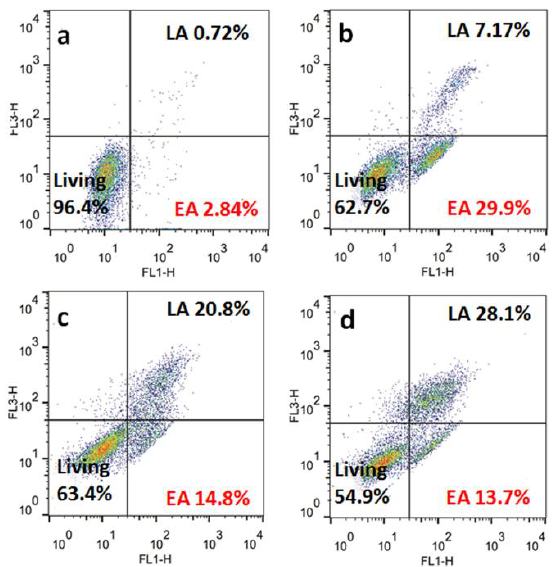
Figure 6. Percentage determination of apoptotic SGC-7901 cells (control, a ) after exposure to 1 (4.0 µ M) ( b ), 2 (15.0 µ M) ( c ), or 3 (15.0 µ M) ( d ) for 24 h. Living, EA, and LA stand for living cells, early apoptotic cells, and late apoptotic cells, respectively.